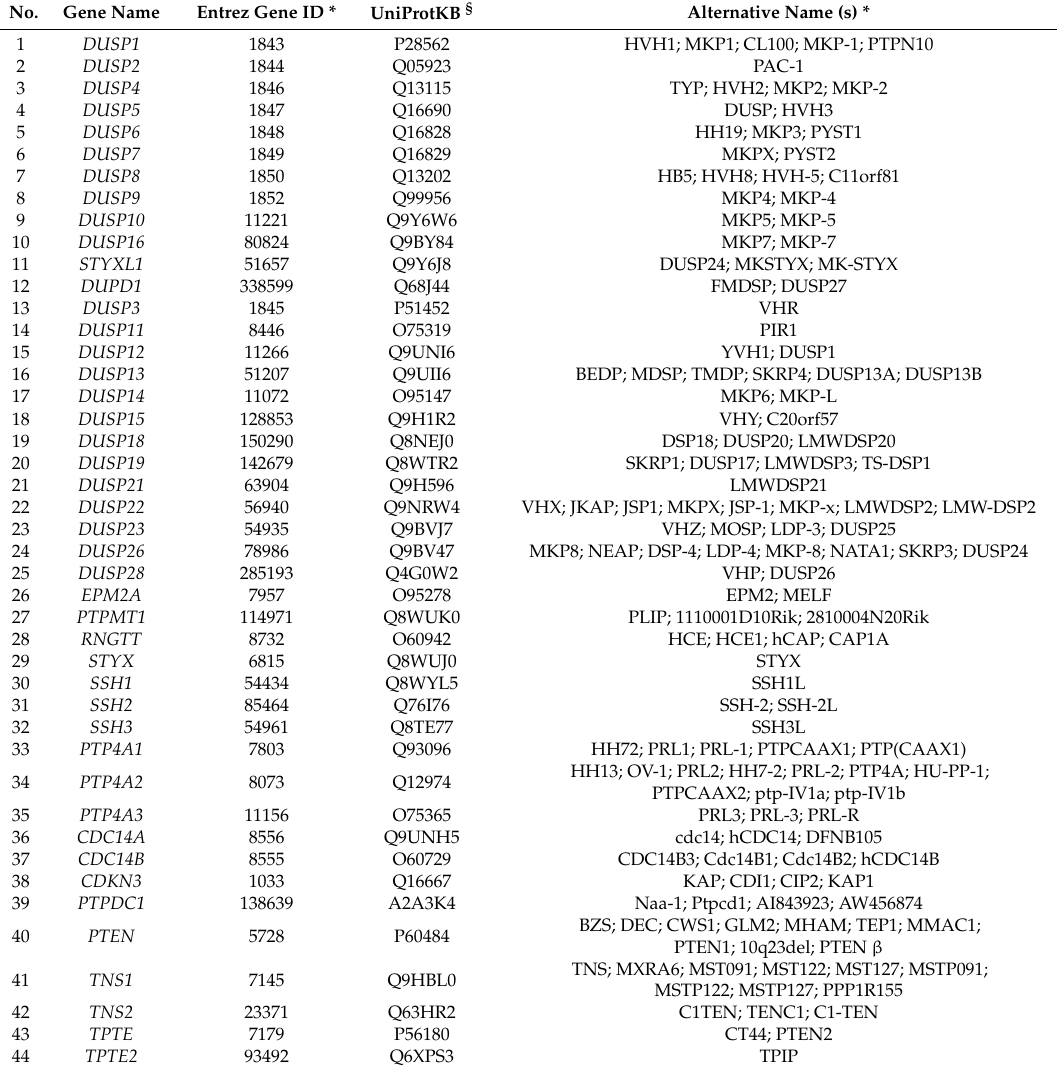
Table A1. List of the Alternative Names of Dual Specificity Phosphatase (DUSP) Family